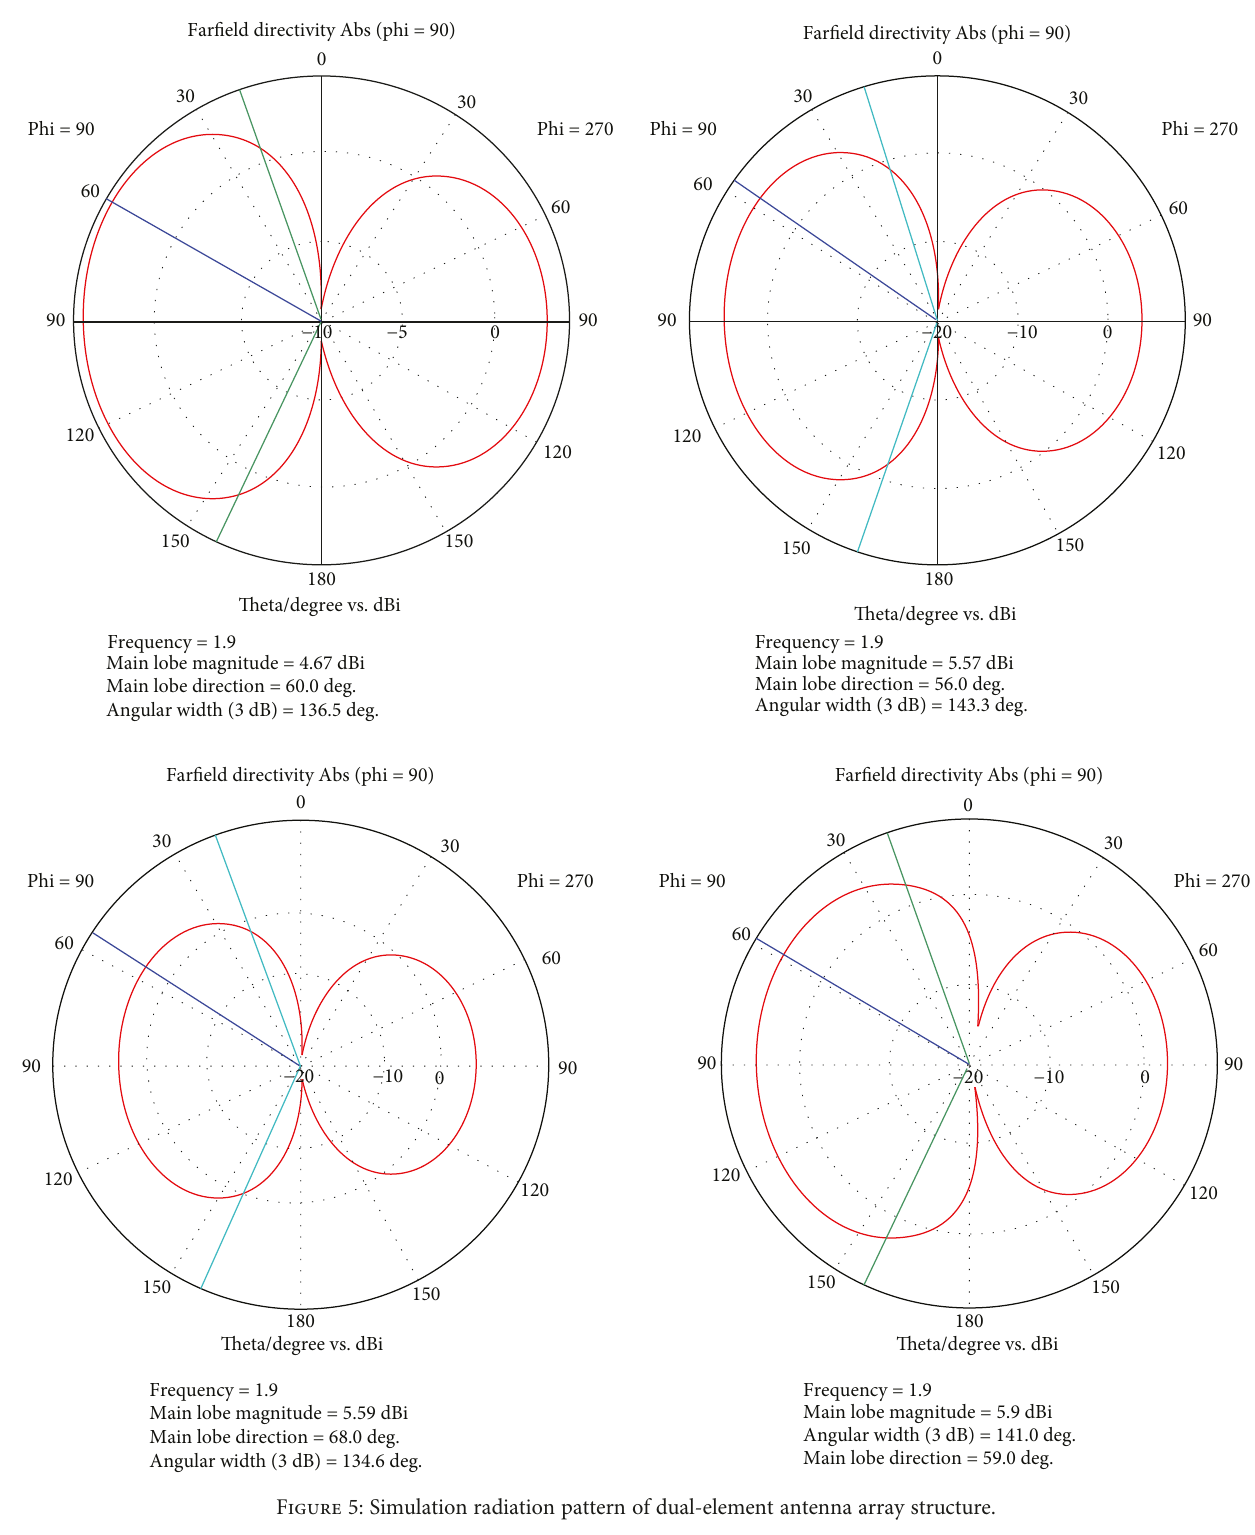
Figure 5: Simulation radiation pattern of dual-element antenna array